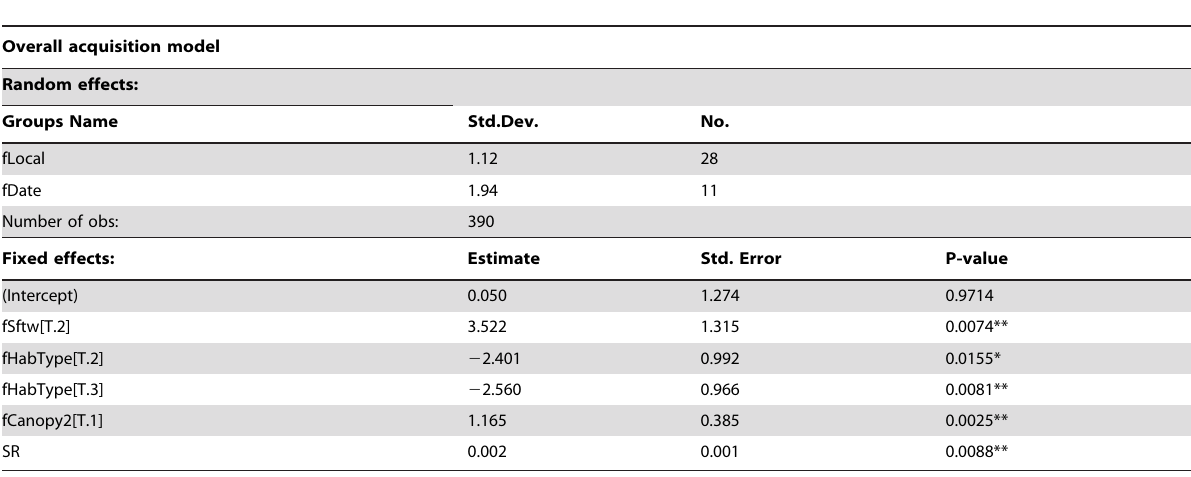
Table 2. Results of the GLMM model to predict GPS fix-success